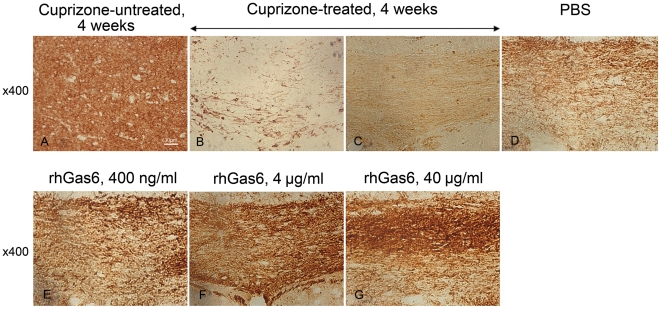
MBP immunostaining shows that rhGas6 treatment enhances remyelination following cuprizone toxicity.Relative to untreated mice (A) there is demyelination of the corpus callosum of mice fed cuprizone for 4 weeks (B and C). A comparison of remyelination assessed by MBP staining of the PBS treated mice (D) versus rhGas6 treatment for 14 days following cuprizone withdrawal (E – 400 ng/ml; F - 4 µg/ml; G – 40 µg/ml of rhGas6) shows that the extent of remyelination is greater in rhGas6-treated mice, ×400.